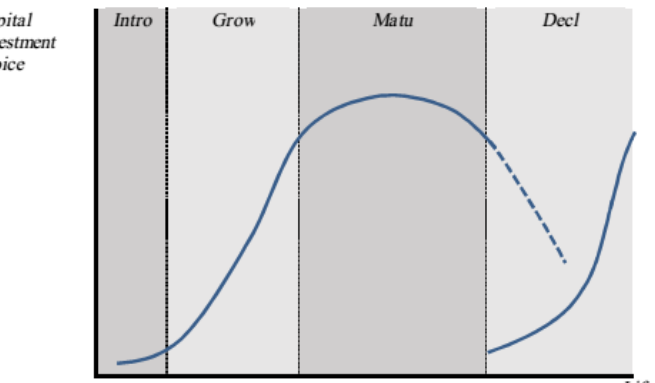
Figure 2. Illustration of relationships between variables